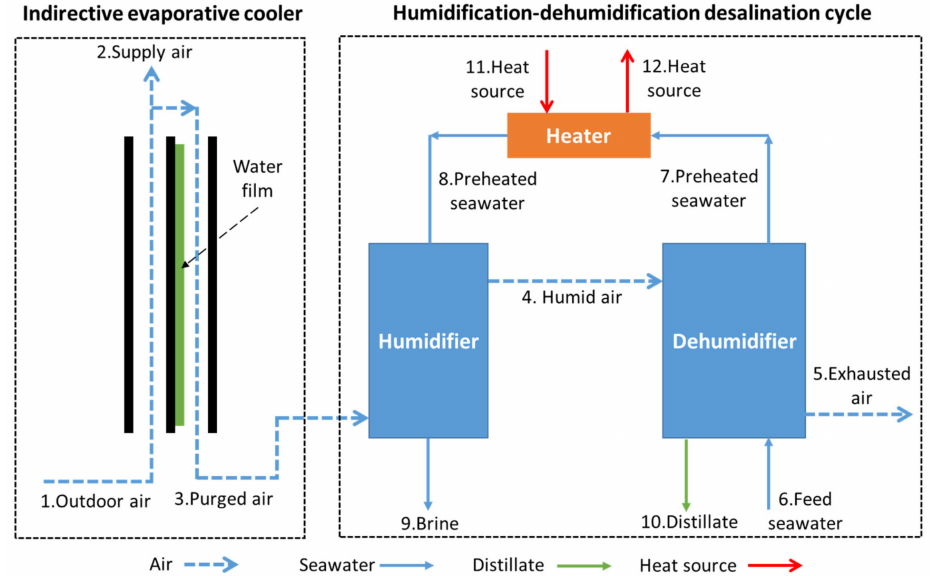
Figure 14. Hybrid IEC-HDH cycle for simultaneous production of cooling and water. Reprinted with permission from Ref. [62]. Copyright 2020,